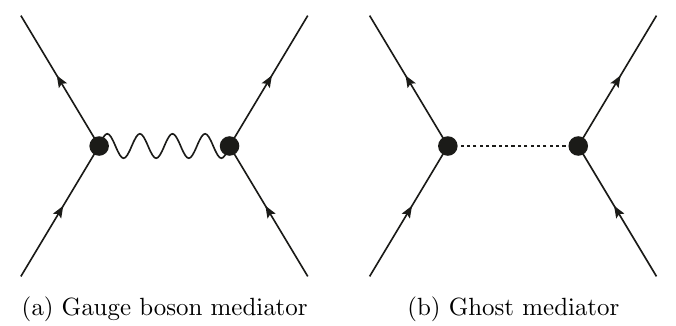
Figure 6. Four point scattering in the extended gauge theory of equation